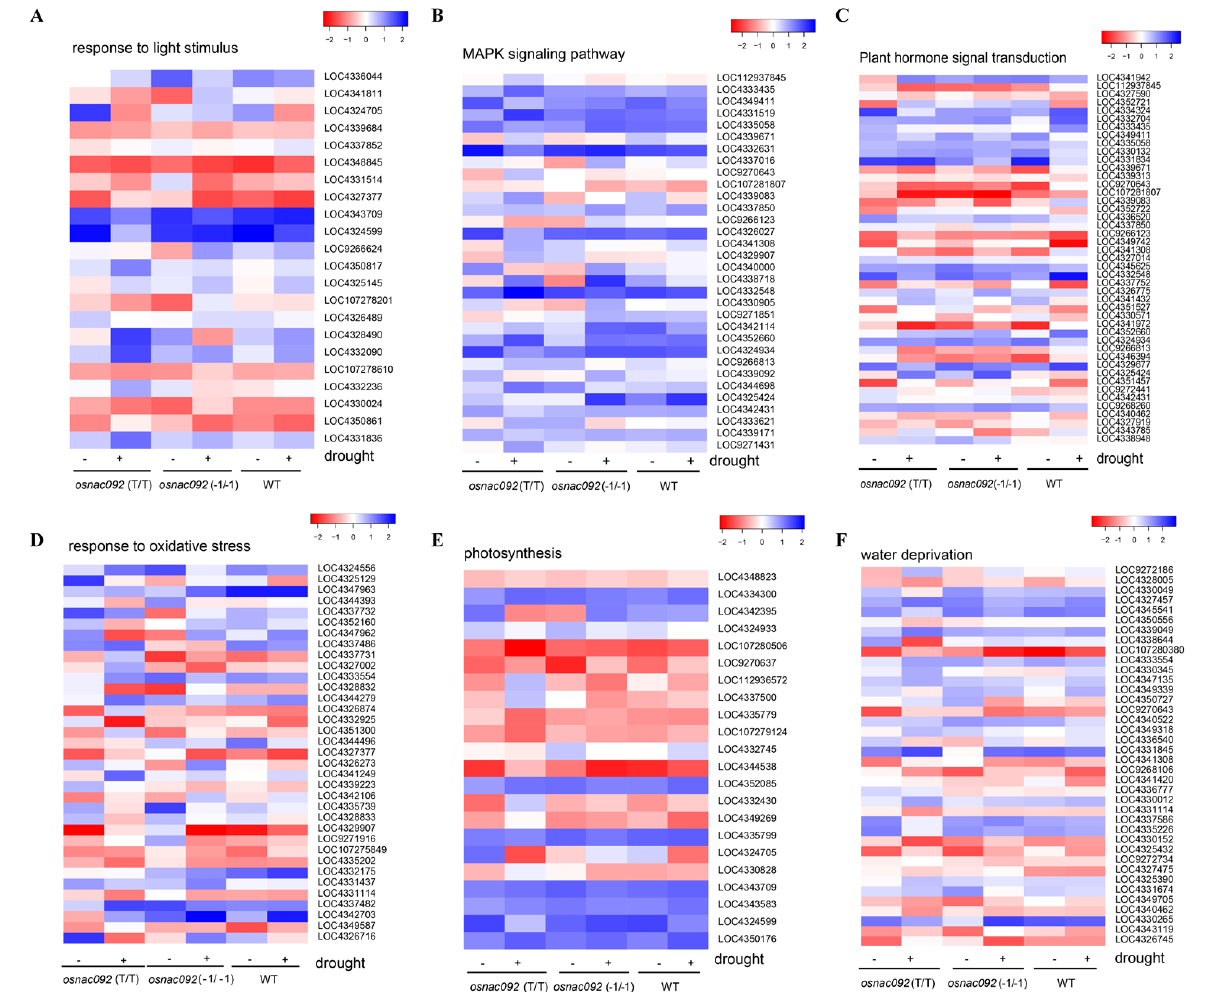
Figure 5. Transcriptome analysis of genes systemically regulated in the wild-type (WT) and osnac092 T2 mutant lines in response to drought stress. ( A ). response to light stimulation. ( B ). MAPK signaling pathway. ( C ). response to oxidative stress. ( D ). photosynthesis. ( E ). plant hormone signal transduction. ( F ). water deprivation.